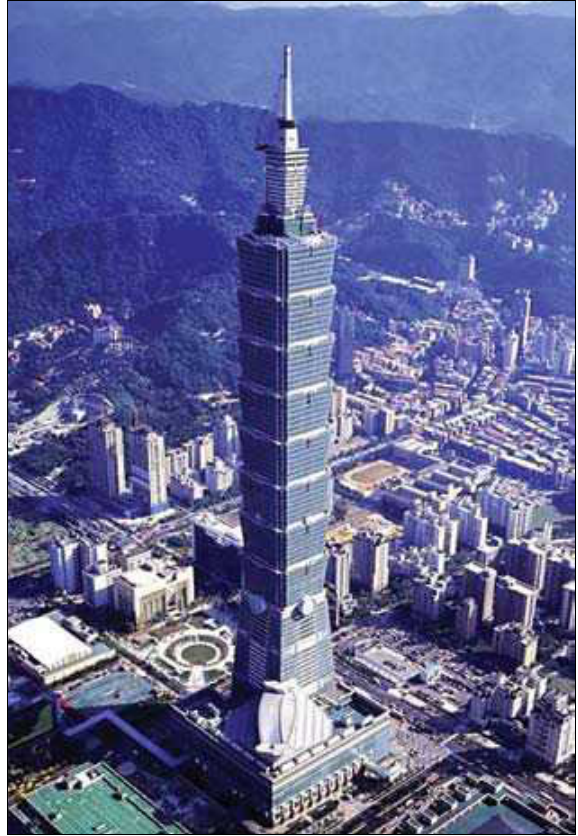
Fig. 6. example of realizing exclusive architecture – taipei 101 tower in taiwan, 2004. architect c. Y.